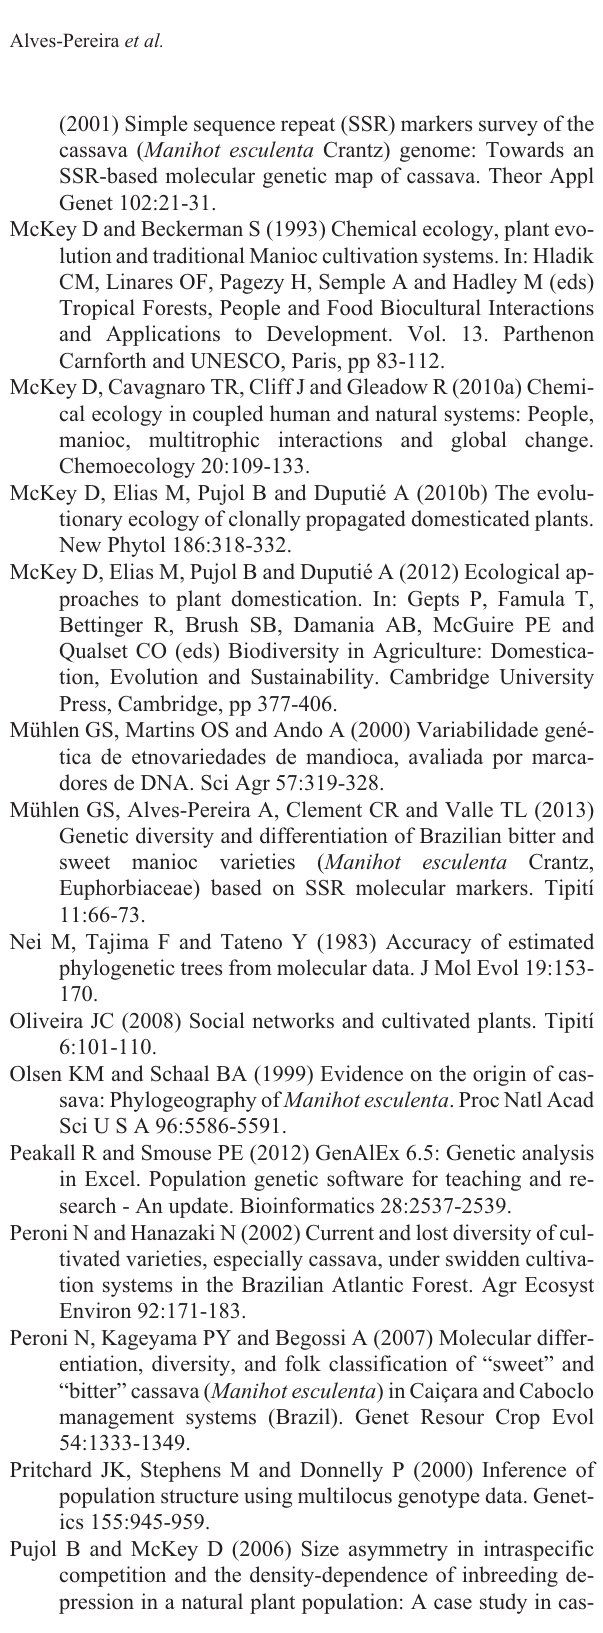
- Table S2 - List of multilocus genotypes (MLGs) across bitter manioc varieties in different soil types in Manicoré, Amazonas, Brazil. - Figure S1 - Criteria for choosing the optimal number of clusters ( K ) for TESS and DAPC, and comparison of indi- viduals’ assignments obtained with DAPC optimized with a-score and